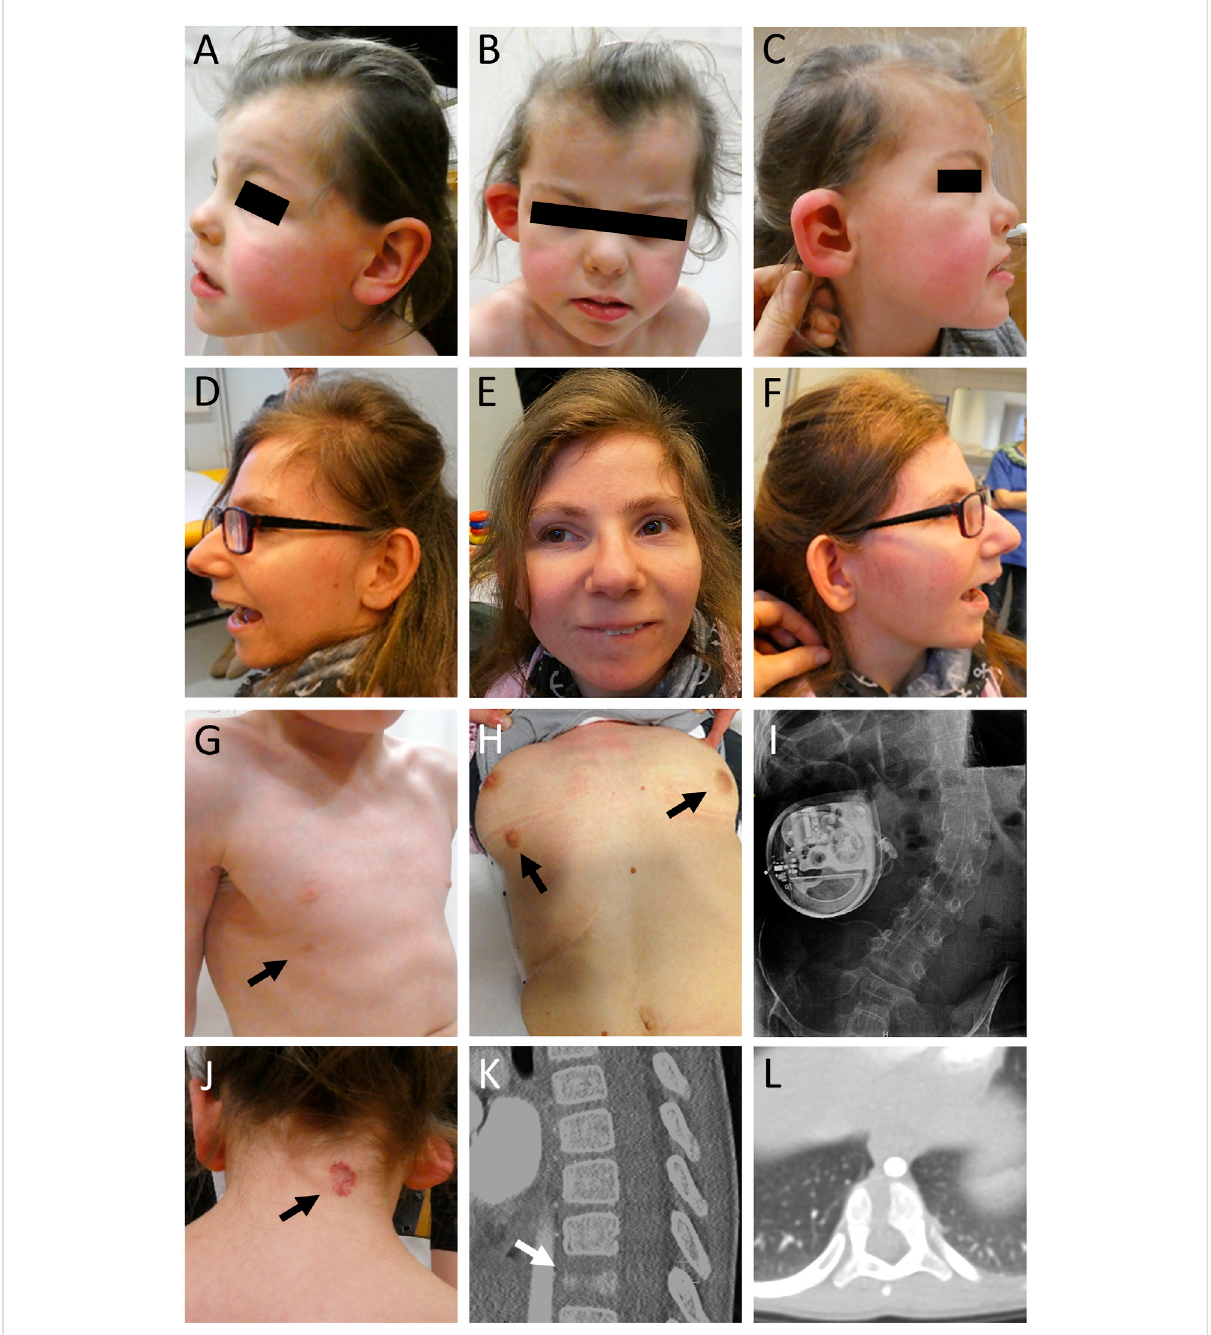
FIGURE 1 Clinical pictures and radiographs of affected individuals. (A – C) Clinical characteristics of individual 1 included microcephaly, facial asymmetry, widow ’ s peak, slightly low-set and posteriorly rotated ears, a protruding dysplastic right ear, prominent eyebrows, a wide nasal bridge, and a thin upper lip. (D – F) Individual 2 showed severe microcephaly, slightly low-set and posteriorly rotated ears, prominent eyebrows, strabismus, a prominent nose, a thin upper lip, and retrognathia. (G) Individual 1 showed a supernumerary nipple only on the right side (indicated by black arrow). (H) Individual2showedbilateralsupernumerarynipplesandbreasts(indicated byblackarrows)as wellas (I) scoliosis.Shereceivedtreatment fordystoniawithabaclofenpump. (J) Inaddition,individual1presentedwithalowposteriorhairline,ahemangioma(indicatedbyblackarrow)onthe neck, (K,L) and a butter fl y vertebra Th11 (indicated by white